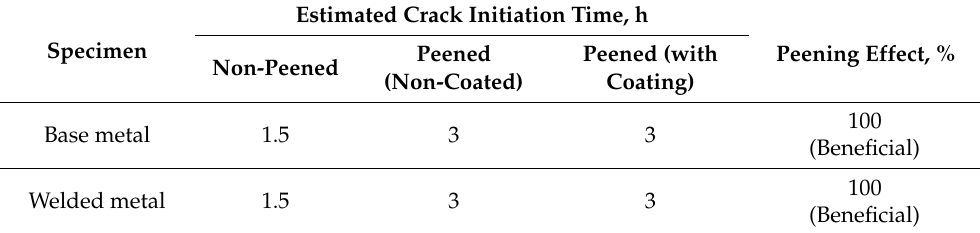
Table 6. Laser shock peening effect on the estimated SCC initiation time of 304L stainless steel in boiling 42% MgCl 2